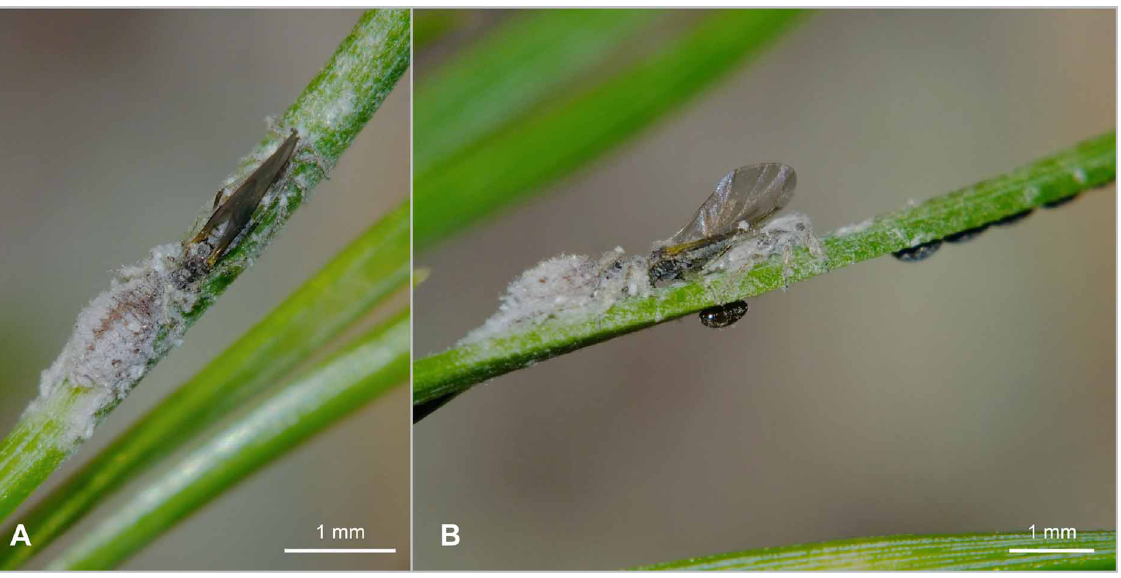
Fig. 85. Schizolachnus pineti (Fabricius, 1781). Aptera, alata, and eggs (in B) on needles of Pinus sylvestris .